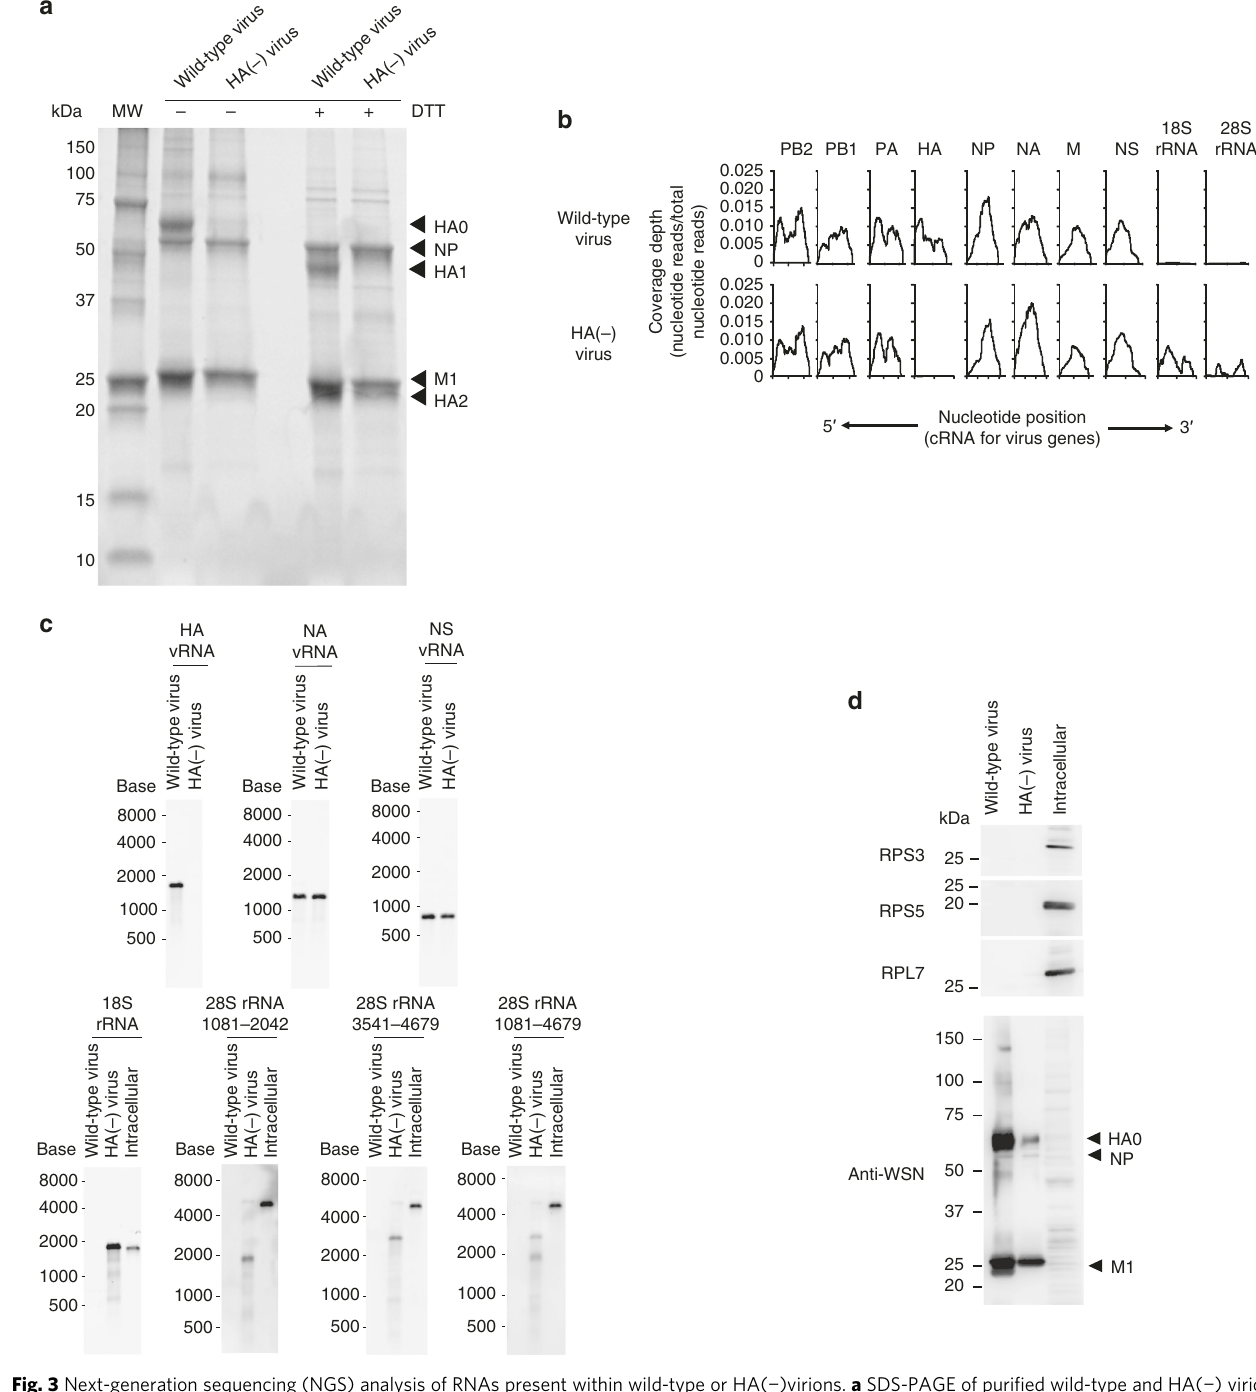
Fig. 3 Next-generation sequencing (NGS) analysis of RNAs present within wild-type or HA( − )virions. a SDS-PAGE of puri fi ed wild-type and HA( − ) virions treated with or without dithiothreitol (DTT) followed by Oriole staining. MW molecular weight marker. b Read coverage over the in fl uenza virus genome. RNAs were extracted from puri fi ed virions and subjected to NGS analysis. Read sets from the wild-type and HA( − ) viruses were mapped onto the in fl uenza A virus genome and 18S and 28S rRNA sequences. Coverage depth is indicated as a ratio (coverage depth per nucleotide/total nucleotides read). The read sets of wild-type and HA( − ) viruses are shown in the upper and lower columns, respectively. Nucleotide positions are indicated in the cRNA-sense for each vRNA. c An equal amount (5 ng) of RNA was subjected to northern blot analysis. The HA, NA, and NS vRNAs, 18S rRNA, and three different 28S rRNA (representing nucleotide positions 1081 – 2042, 3541 – 4679, and 1081 – 4679) speci fi c riboprobes were used for detection. Intracellular RNAs from uninfected MDCK cells were used as a control. d Puri fi ed wild-type virions, HA( − ) virions, and cell lysates were subjected to western blot analysis using anti-RPS3, anti-RPS5, and anti-RPSL7 antibodies and an anti-whole in fl uenza virion polyclonal